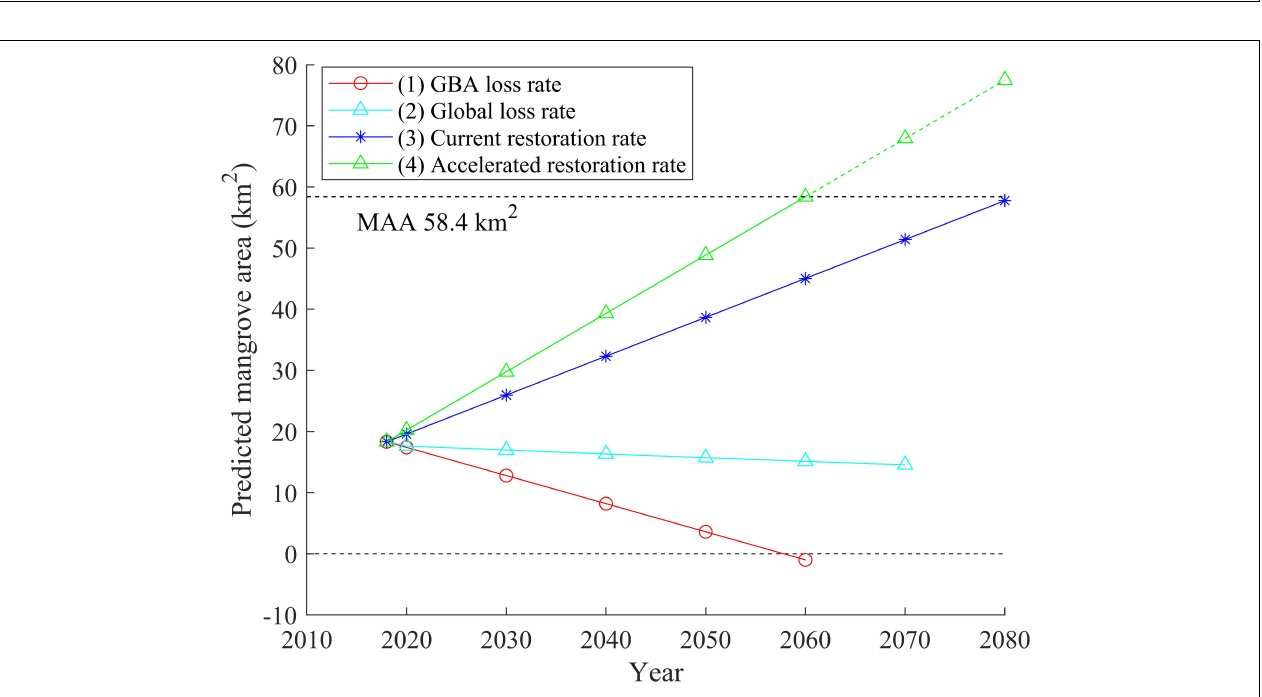
Frontiers in Marine Science |